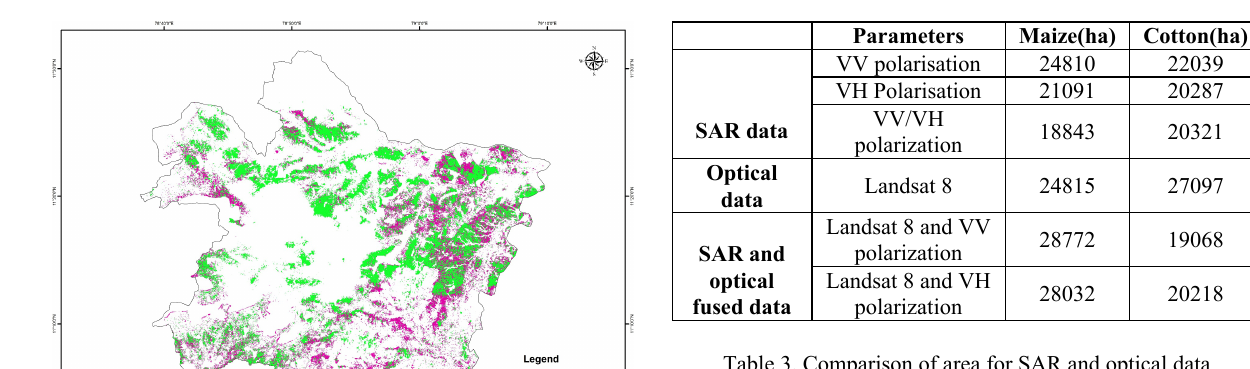
Table 3. Comparison of area for SAR and optical